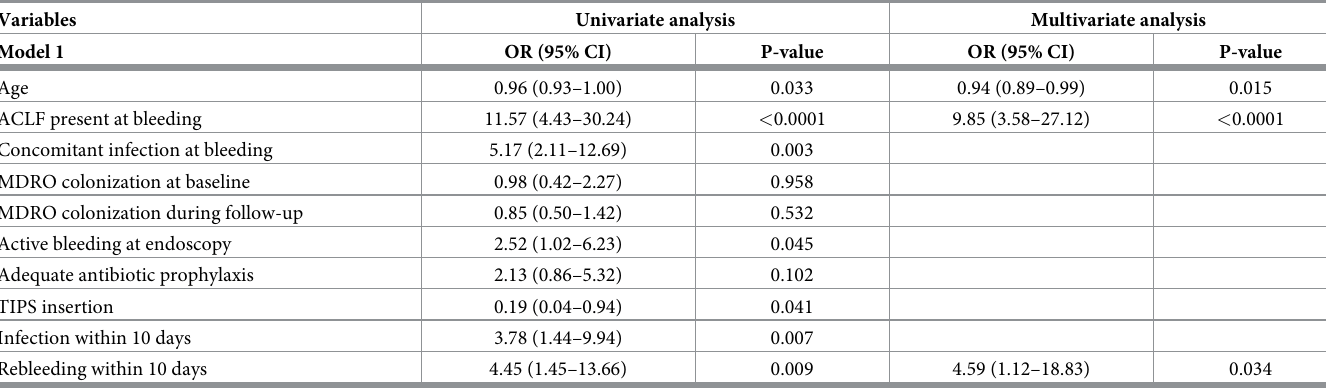
Table 4. Uni- and multivariate logistic regression analysis investigating risk factors for death or liver transplantation after one year. Variables Univariate analysis Multivariate analysis